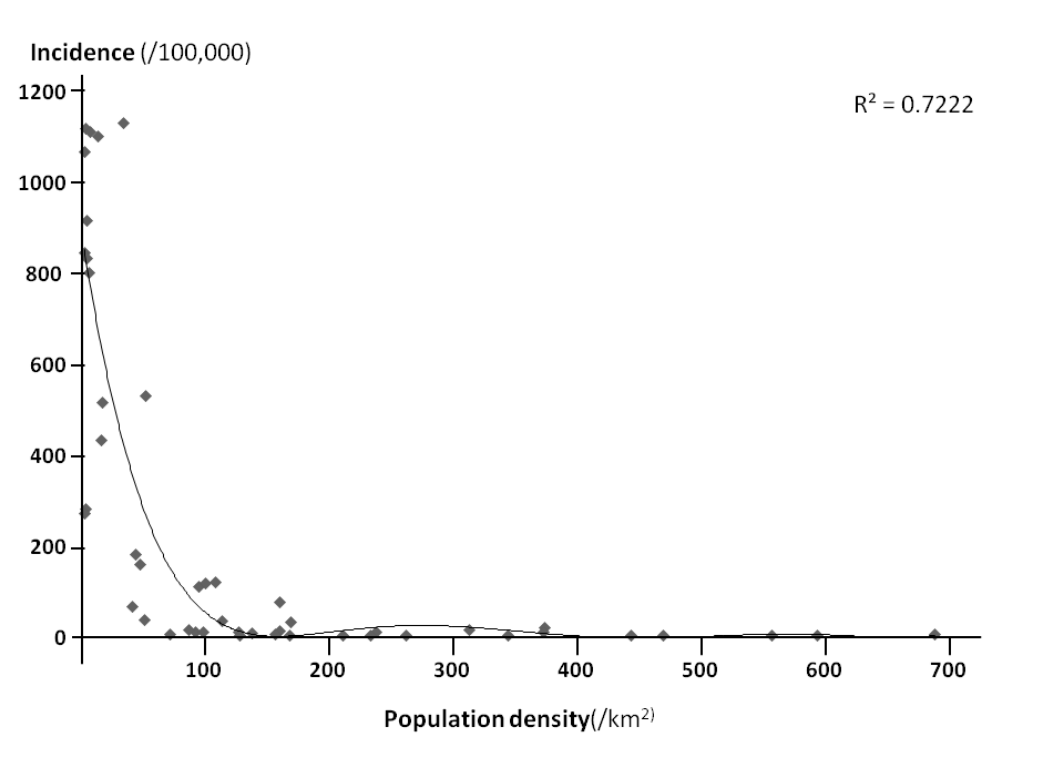
Figure 11 . Relationship between scorpion sting incidences and human population densities in Algeria